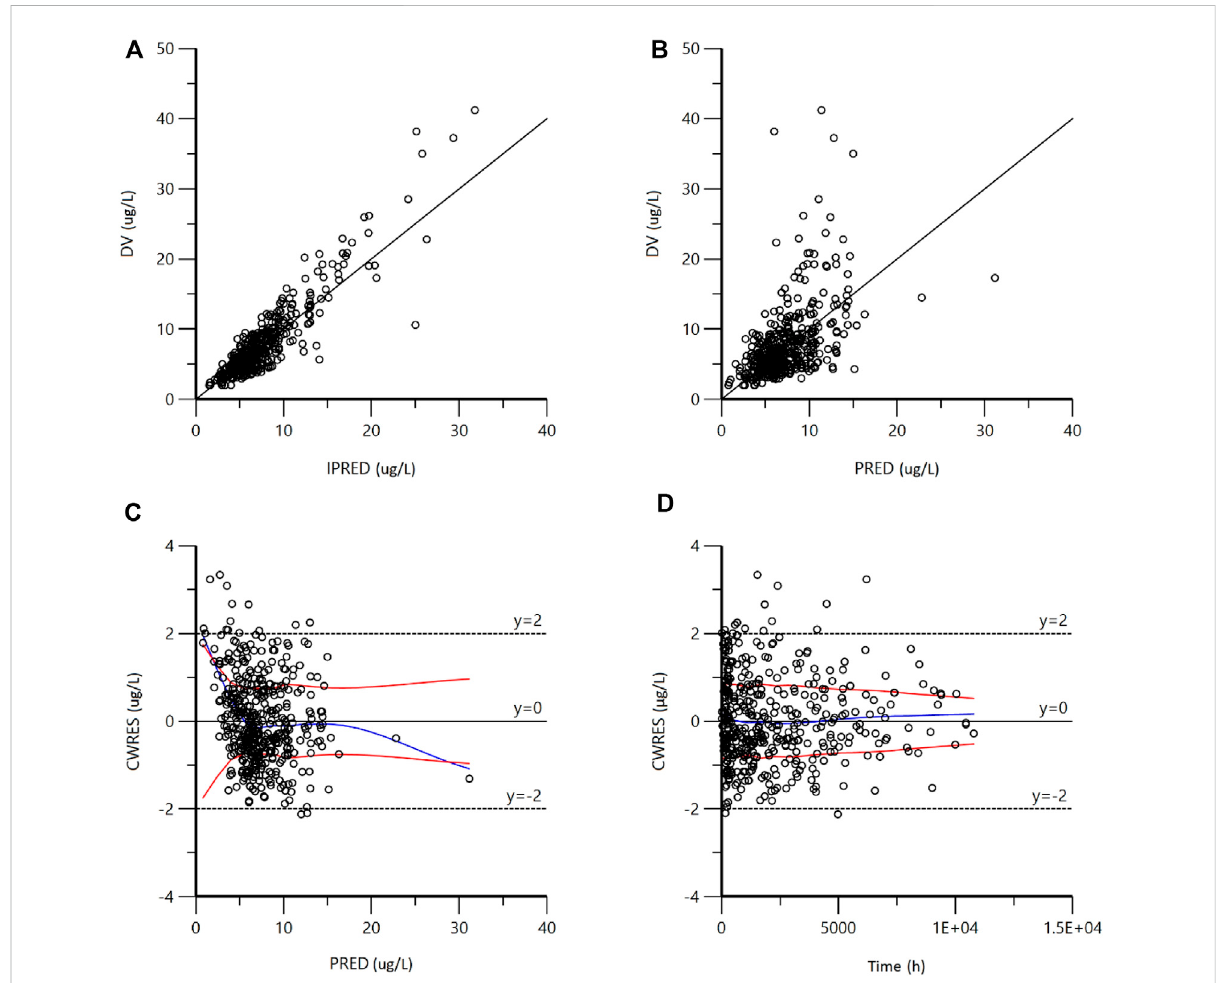
FIGURE 2 Goodness-of- fi tplotsfor the fi nalmodel. (A) Observedconcentrations (DV) vs. individual predictions (IPRED); (B) DV vs. populationpredictions (PRED); (C) conditionalweightedresiduals(CWRES)vs.PRED; (D) CWRESvs.Time).Asshownin fi gures (A,B) ,thescatterpointsgeneratedbythe fi nal modelareevenlydistributedonbothsidesofthereferenceline;asshownin fi guresCandD,theresidualscatterpointsaresymmetricallydistributed. Most of them are in the range of ( − 2 ~ + 2), which proves that there is no obvious bias in the prediction